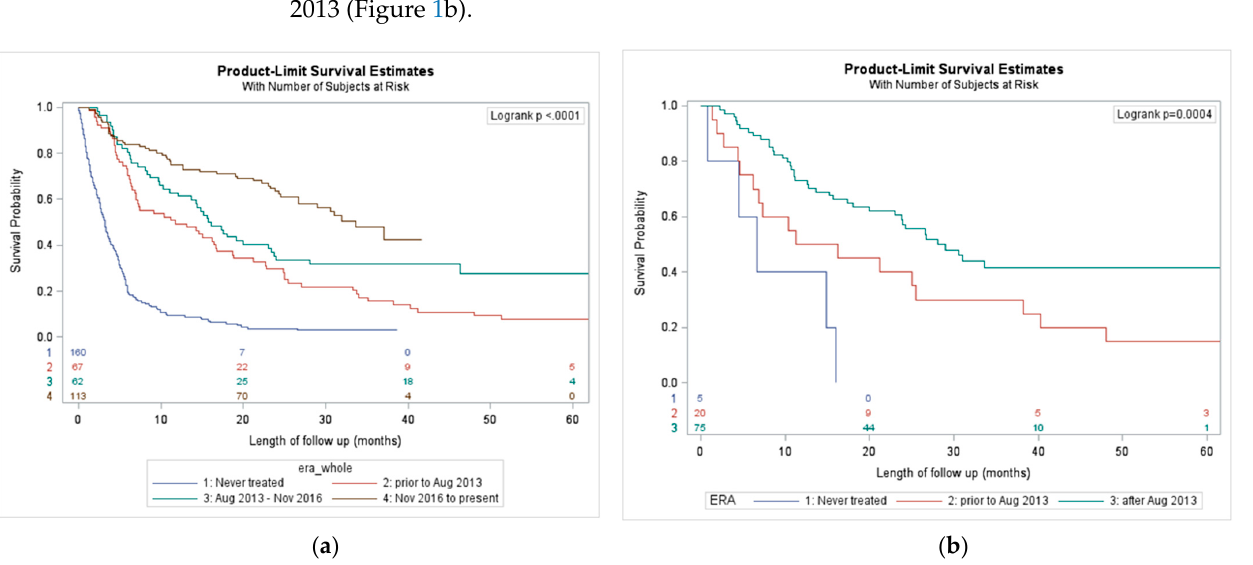
( c ) Figure 1. ( a ) Overall survival outcomes by era of novel therapy; ( b ) overall survival outcomes by era in BRAF mutant- melanoma; ( c ) overall survival outcomes by era in unknown or wild-type BRAF mutation status. BRAF mutant melanoma patients that never received treatment had a median OS of only 6.6 months. The same trend appeared for unknown or BRAF wild-type patients. Over the successive treatment eras, there was improvement in median OS: 12.4 months for prior to May 2014, 16.8 months for May 2014–November 2016, and 37.0 months for November 2016 to July 2020 (Figure 1C). In BRAF wild-type or unknown status patients, those who did not receive any treatment had a median OS was 3.2 months. 3.3. Outcomes by First Treatment Received In the 100 patients with BRAF mutant melanoma, the median survival for first line Dabrafenib and Trametinib was 17.4 months (Figure 2A). The median survivals were even better in the first-line immunotherapy groups. The median survival was not reached in the first-line PD-1 inhibitors or combination ipilimumab and nivolumab arms, however, the one-year survival for ipilimumab and nivolumab was superior to the single-agent PD- 1 inhibitor groups.